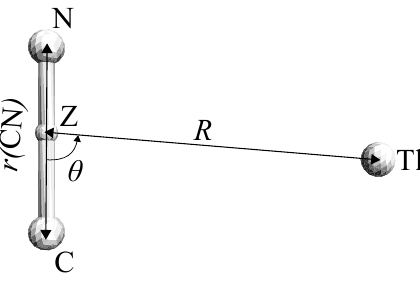
Figure 1. Internal coordinates R , r ( CN ) , θ for the Thallium Monocyanide (Tl · CN) system. Z is the center of mass of the CN fragment, θ = 0 o and θ = 180 o correspond to the linear TlCN and TlNC structures,